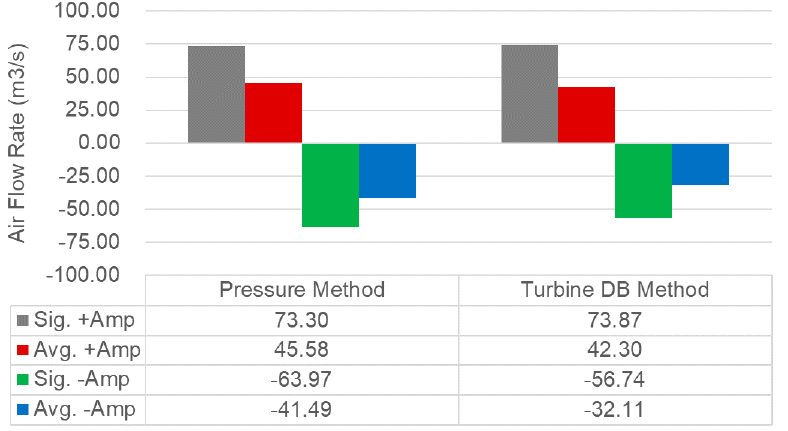
Figure 7. Comparison of statistics between pressure method and turbine DB method.